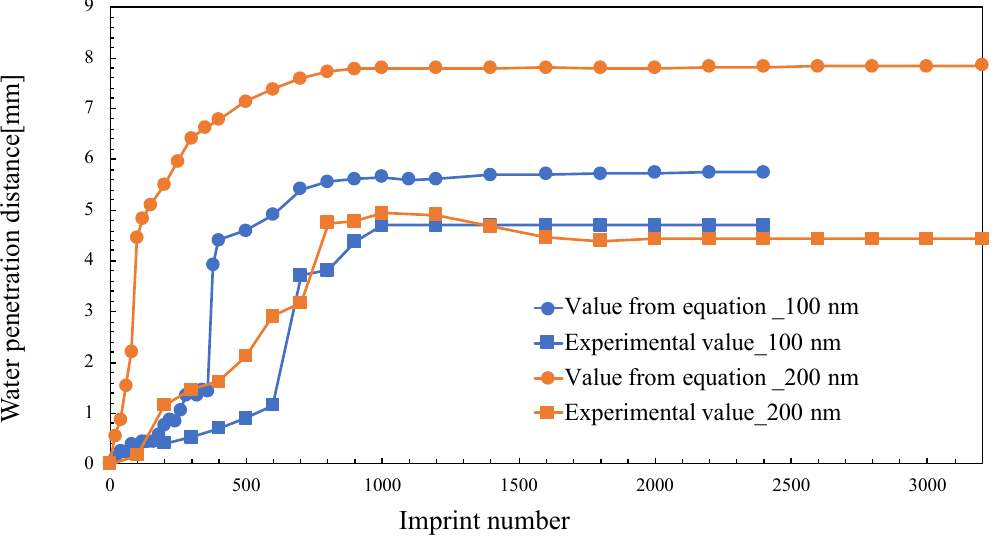
Table 1. Values assigned to Equation (5) for water penetration distance .